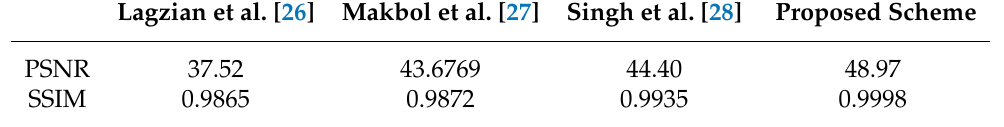
Table 11. Imperceptibility comparison values in terms of PSNR (db) and SSIM for Lena image of Lagzian et al. [26], Makbol et al. [27], Singh et al. [28], Chen et al. [45] and the proposed method using a watermark of size 256 × 256.